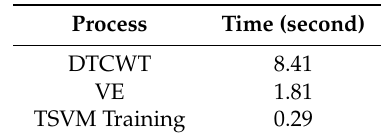
Table 6. Offline-Learning Computation Time.